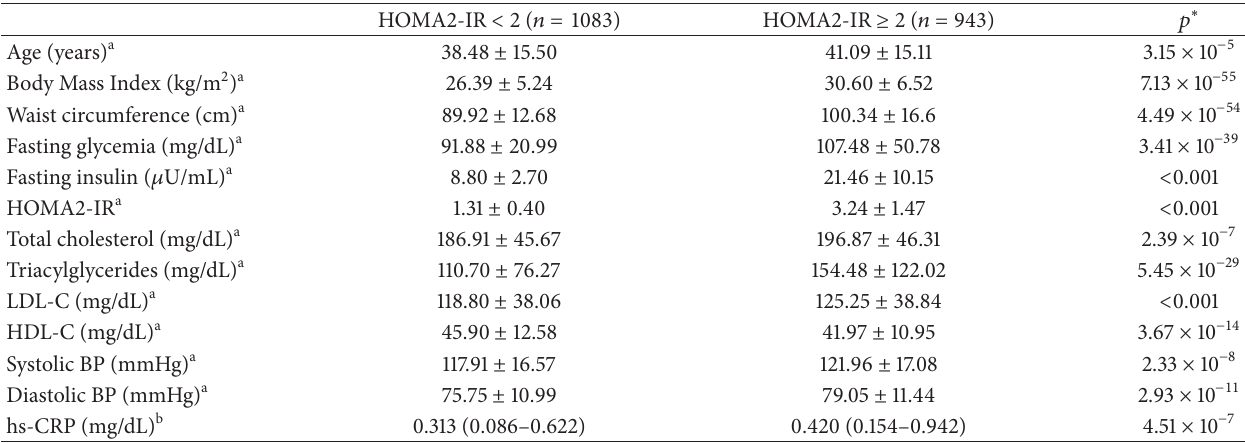
Table 7: Biologic and anthropometric characteristics in the general population by insulin resistance status (Maracaibo, Venezuela,